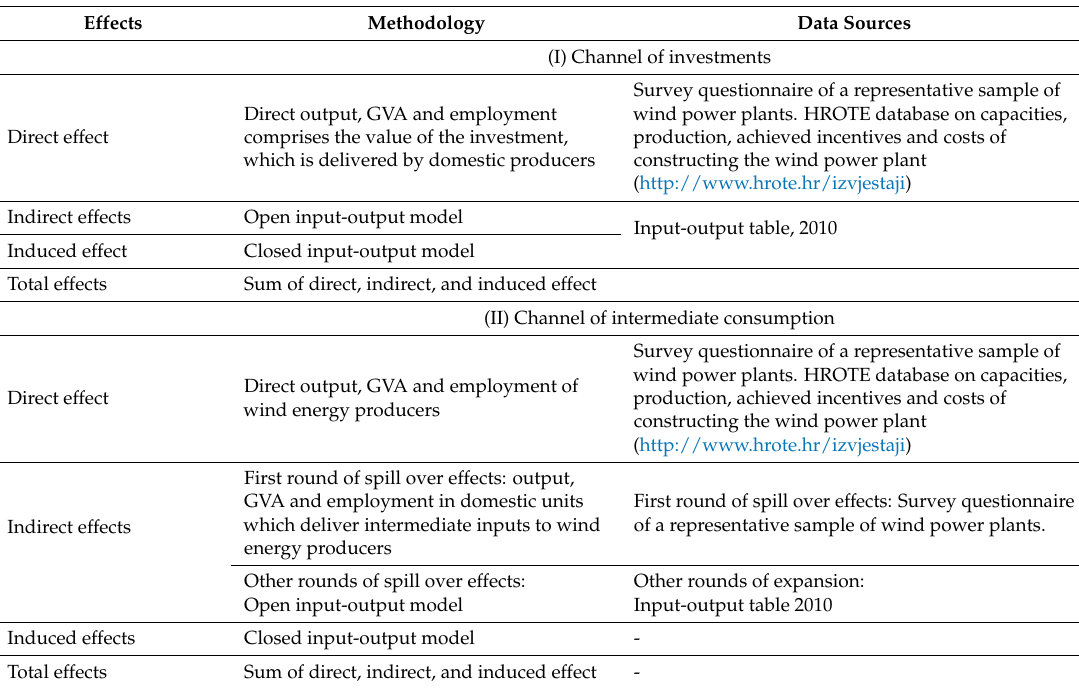
Table 1. An outline of the methodology, data sources and variables used in estimation of effects related to wind power plant